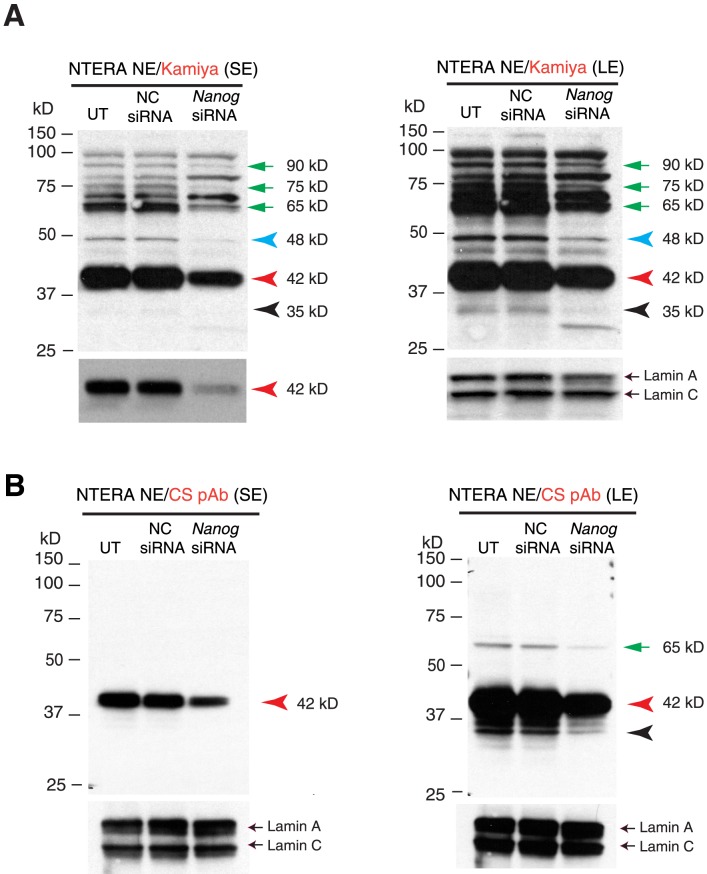
Characterization of Nanog proteins in NTERA-2 cells upon siRNA-mediated knockdown.(A) Nanog siRNA experiments in NTERA-2 cells. NTERA-2 cells were transfected with a pool of Nanog-specific siRNAs for 48 h, harvested, and used to isolate the NE for WB with the Kamiya Ab. The left and right panels represent the short and long exposure (SE and LE, respectively) films (note that the left bottom panel is the shortest exposed film to illustrate the significant knockdown of the 42 kD band). Lamin A/C was the loading control. UT, untransfected; NC siRNA, negative control (siCONTROL non-targeting) siRNAs; Nanog siRNA, SMARTpool siRNA against Nanog. Red, black, and blue arrowheads indicate the major 42 kD, minor 35 kD, and 48 kD protein bands, respectively, that were reduced upon Nanog knockdown. The green arrows refer to additional bands that also showed reduction. (B) The WB was performed with the CS anti-Nanog rabbit pAb.